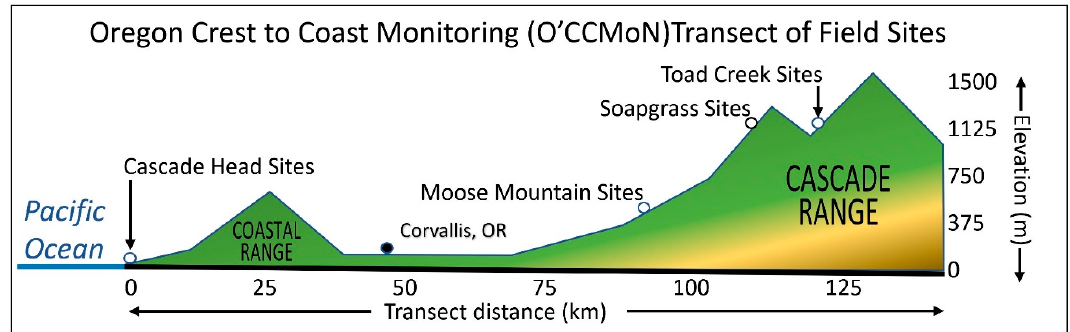
Figure 4. EPA Oregon Crest-to-Coast Environmental Monitoring (O’CCMoN) transit sites with environmental West to East trends and details for the sites used in this study. Figure adapted from the Crest to Coast Overview document [28].